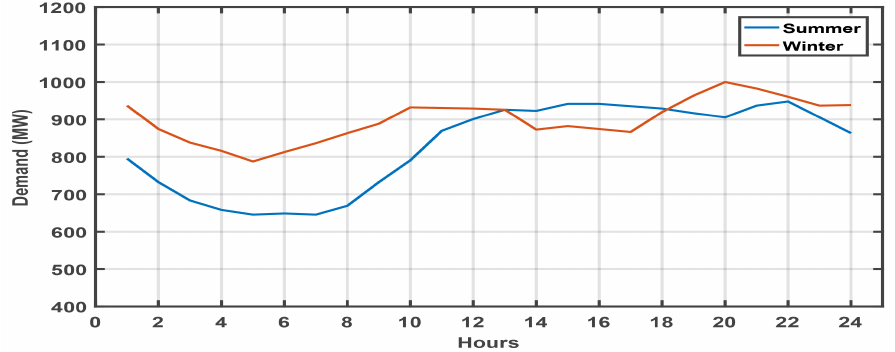
Figure 4. Hourly demand on Jeju Island.